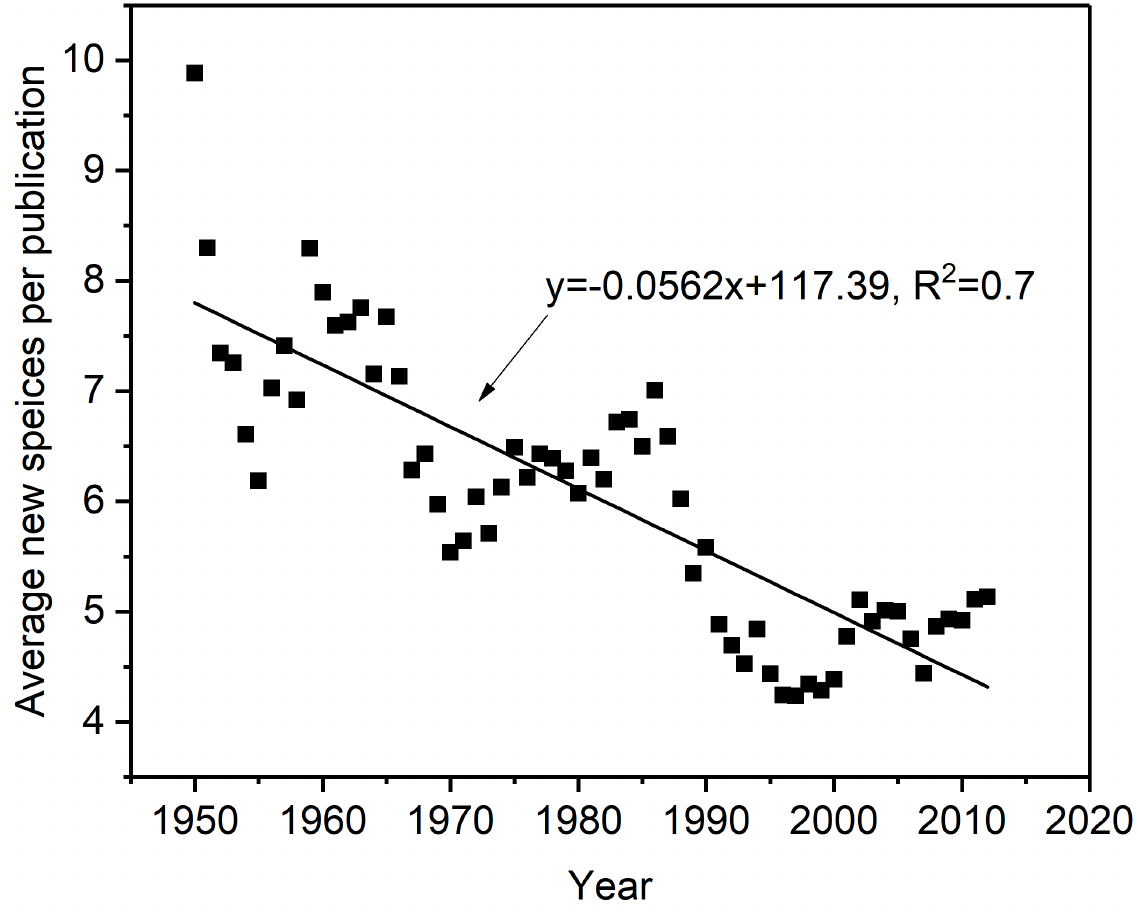
Fig 2. Average new species described per article (Cicadellidae, Miridae, Pyralidae and Staphylinidae combined) from 1946 to